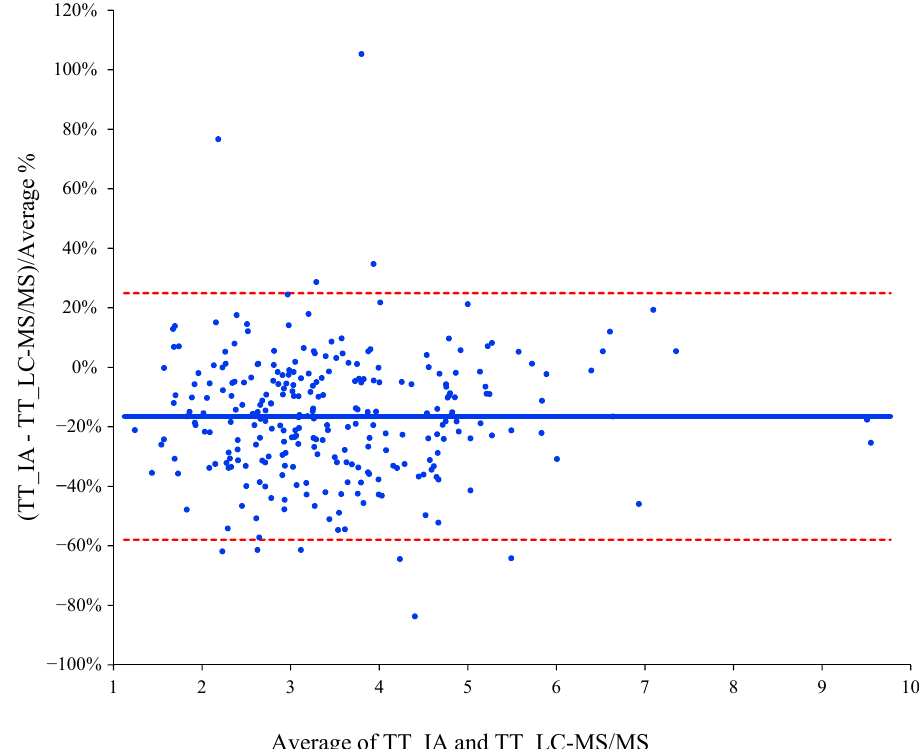
Figure 2. Bland–Altman bias plots for comparisons between the LC-MS/MS method and the IA. The solid line represents the relative mean difference between paired measurements; the dashed line indicates the upper and lower limits of agreement which approximate the mean measurement discrepancy ± 1.96 standard deviations.